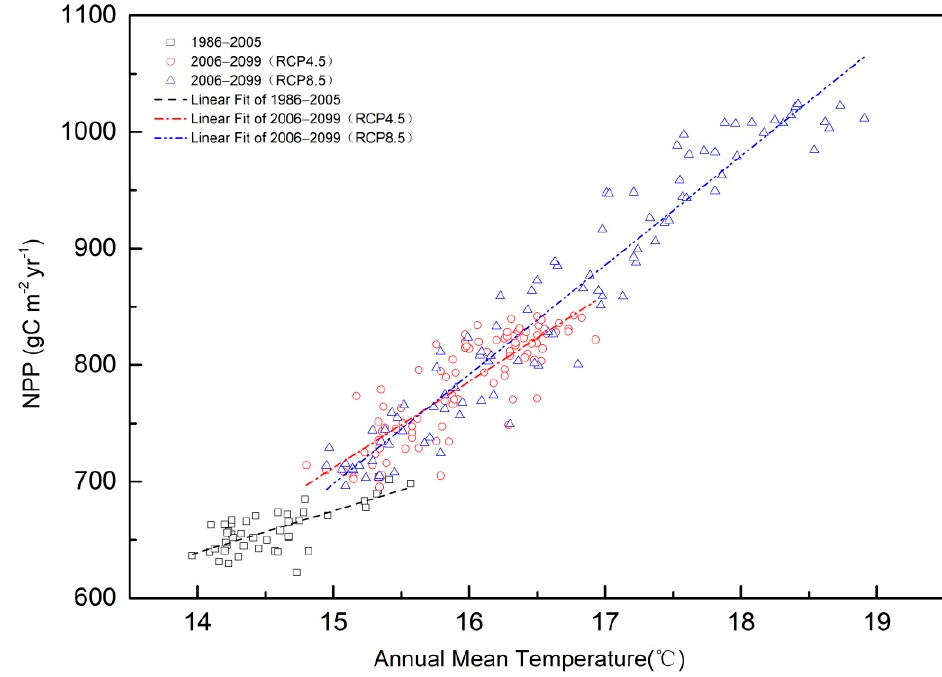
Figure 4. Effects on vegetation NPP and the growth rates of mean air temperature under different scenarios in the